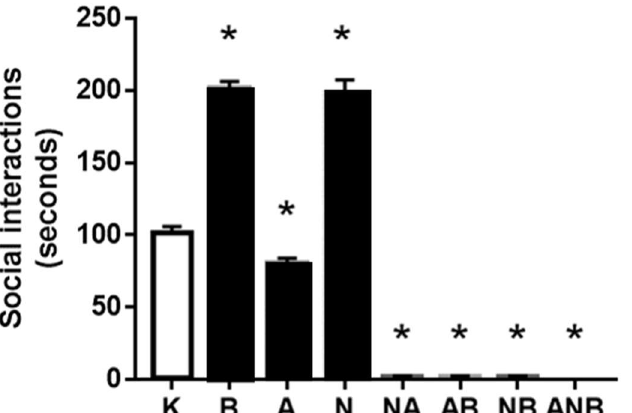
Figure 3. Social interaction. The results for social interaction (s) in open field in the ketamine-induced social interaction test (SIT), mean values, and 95 percent confidence intervals are presented. In the ketamine rats (8 mg/kg ip/3 days), medication (mg/kg ip) was at the last ketamine challenge: L-NAME (5) (N), L-arginine (100) (A), BPC 157 (0.01) (B), alone and/or together (L-NAME+L-arginine (NA), L-arginine+BPC 157 (AB), L-NAME+BPC 157 (NB), L-arginine+L-NAME+BPC 157 (ANB)), and saline 5 mL/kg ip (control ketamine) (K). The application was immediately before ketamine (L-NAME, L-arginine, and combination) or the application was immediately after ketamine (BPC 157 and combinations). Dunnett’s multiple comparison test was used to compare control group (K) with treated groups. * p < 0.05 relative to